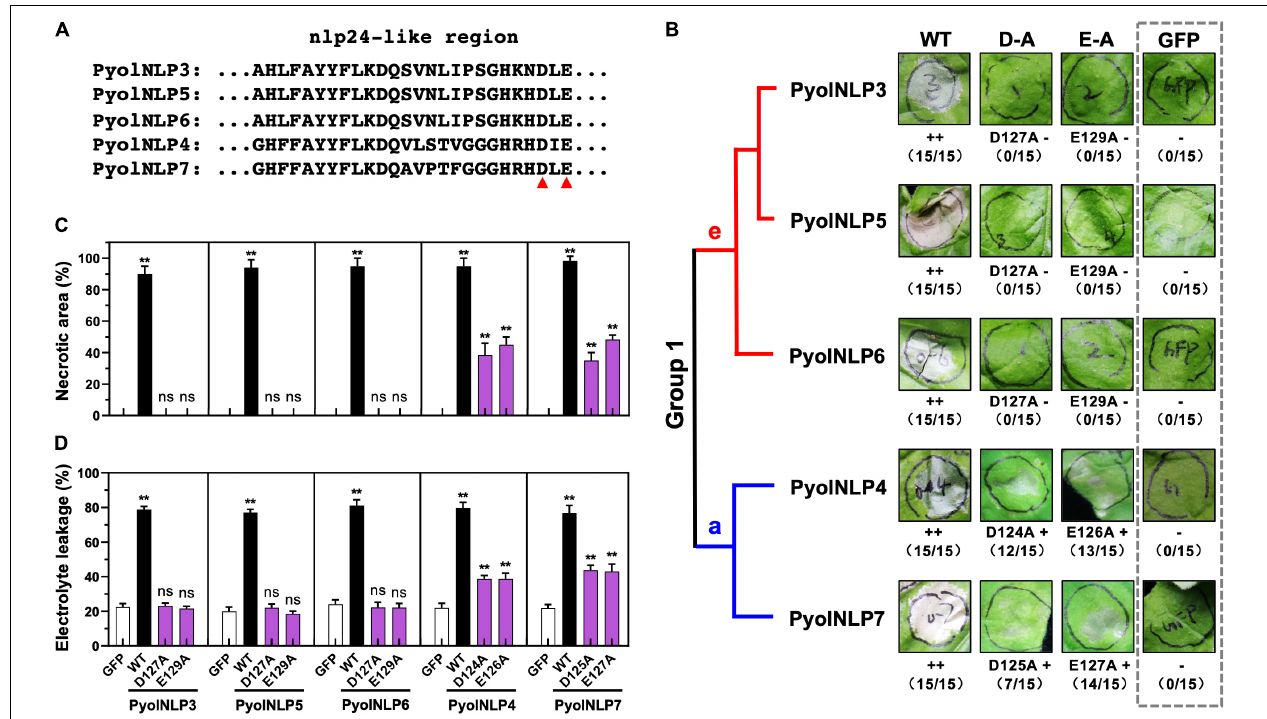
FIGURE 1 | Conserved D and E in the “GHRHDLE” motif are essential for the necrosis-inducing activity of Group 1 PyolNLPs. (A) Schematic representation of nlp24-like regions from PyolNLP3-7. Aspartic acid (D) or glutamic acid (E) residues marked by the red triangle is replaced by alanine (A). (B) The necrosis-inducing activity of wild-type and mutated Group 1 PyolNLPs in agroinfiltrated Nicotiana benthamiana leaves. Necrosis grades are marked (–: no necrosis; + weak necrosis; + + : strong necrosis). The phylogenetic tree of selected Group 1 PyolNLPs are shown on the left. Amino acid mutations, necrosis grades and experiment replicate numbers (necrotic sites versus total infiltration sites) are labeled. The gray dotted rectangle green fluorescent protein (GFP) is shown as a negative control. Photos were taken at 5 days post infiltration (dpi). Quantification of necrosis by measurements of relative (C) necrotic area and (D) electrolyte leakage. Error bar represents mean ± SD ( n = 3). Data were analyzed by Median-edition Levene’s test to determine the homogeneity of variance across groups, and then analyzed by one-way ANOVA with post-hoc Tukey’s range test for groups with equal variance (ns, no significant difference; ** P < 0.01). All experiments were repeated three times with similar results